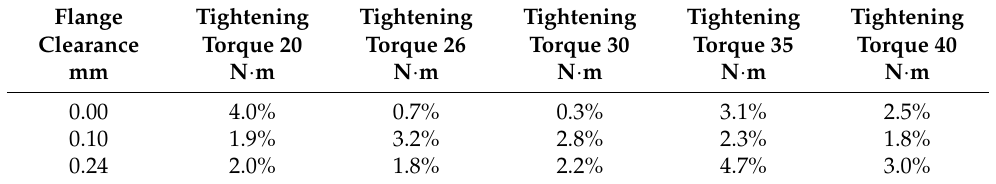
Table 4. Relative deviation table of the contact area ratio for the two